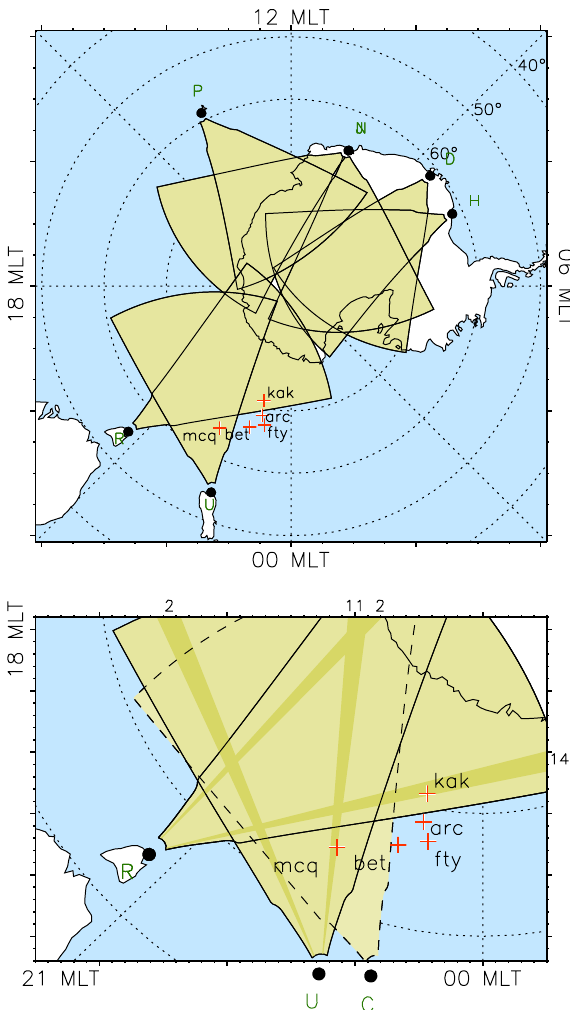
Fig. 1. The fields-of-view of the full southern hemisphere Super- DARN array, presented in a magnetic local time- (MLT) magnetic latitude coordinate system (in the northern hemisphere) such that dusk is to the left and dawn is to the right. The region containing the TIGER radar pair is enlarged in the bottom panel, which is the same region in which flow and auroral data are displayed. Beams 2 and 11 of the TIGER Unwin radar (U) and beams 2 and 14 of the TIGER Bruny Island radar (R) are indicated by the darker shaded regions of the fields-of-view and labelled on the top and right-hand axes. The field-of-view of the (northern hemisphere) King Salmon radar, is shown dashed. Also shown on both panels are the location of the MacQuarie Island magnetometer, which is located close to the onset region of the substorm, and the locations of four magne- tometers from the northern hemisphere Alaskan